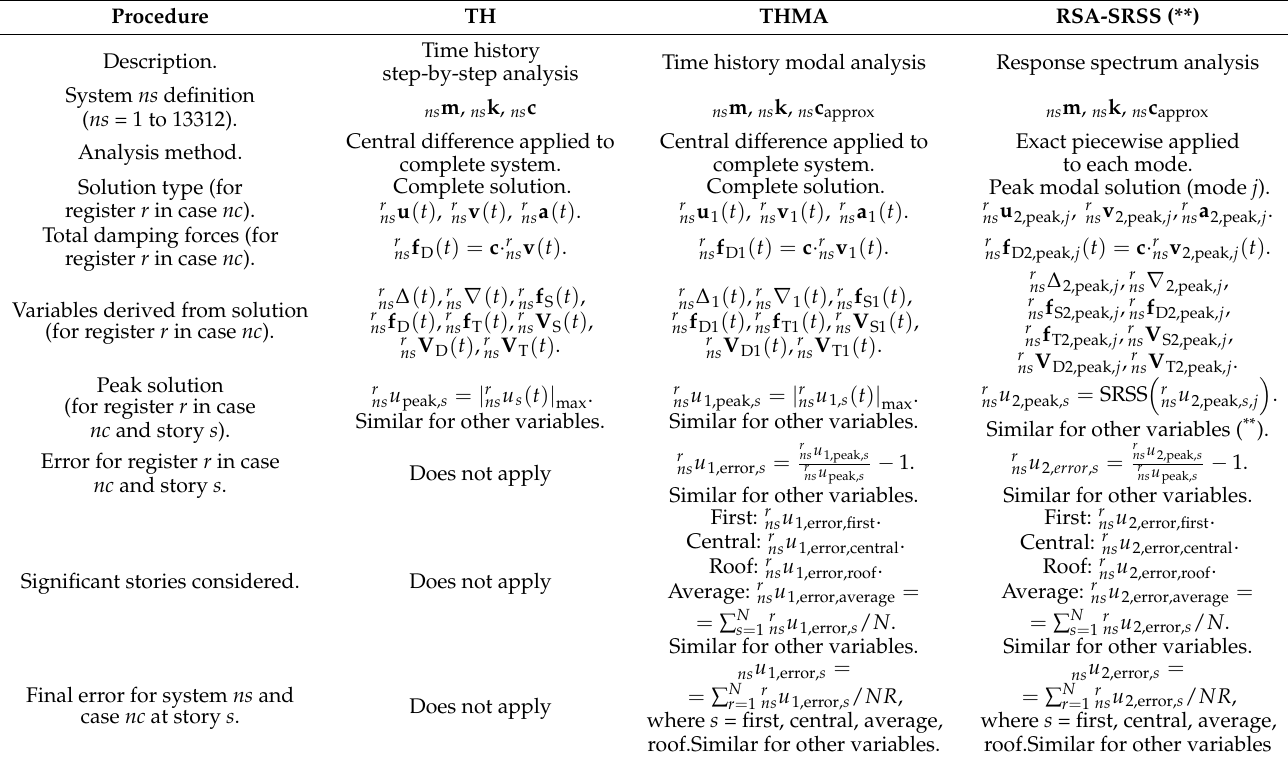
Table 1. Summary of procedures and notation used in the numerical